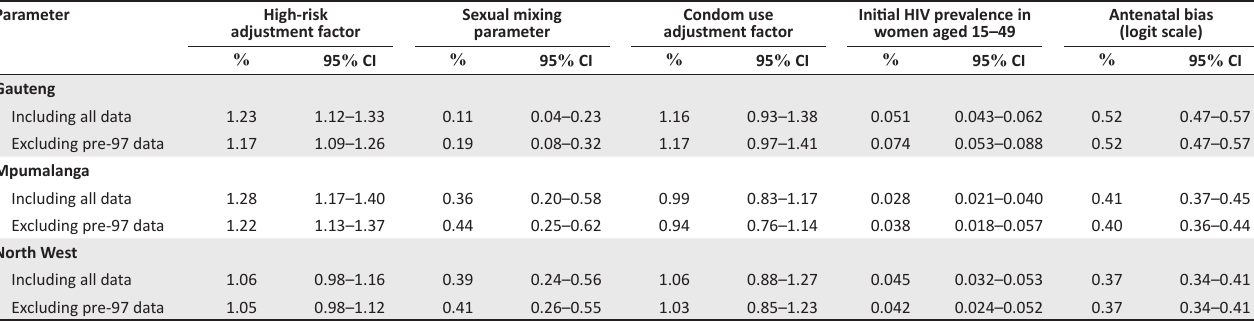
same for all provinces, and the horizontal lines, therefore, represent the prior mean and 95% confidence interval. FIGURE 1: Comparison of prior and posterior distributions. TABLE 2: Posterior estimates of model parameters before and after excluding pre-1997 data.